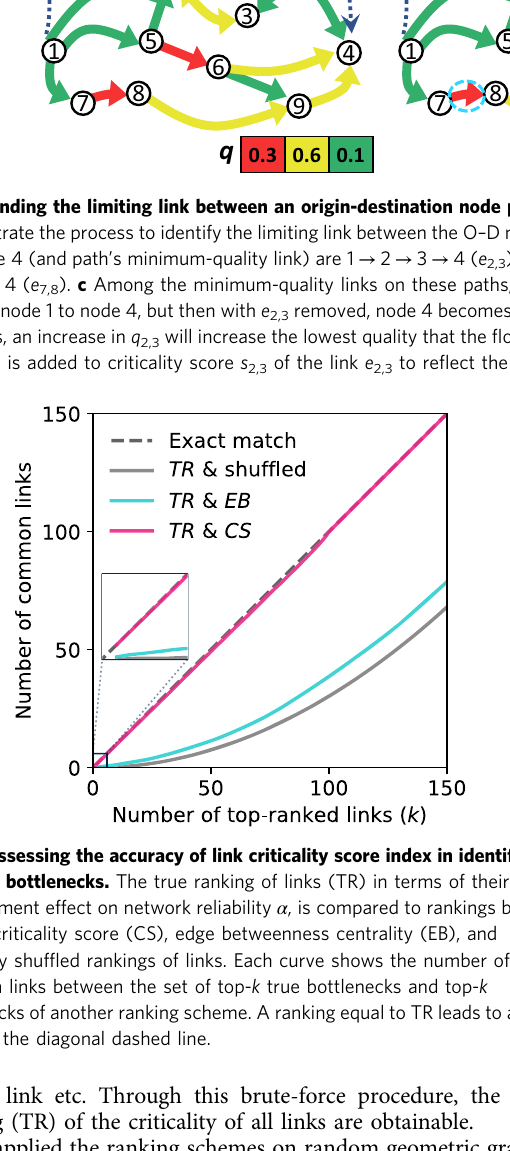
ranking (TR) of the criticality of all links are obtainable.